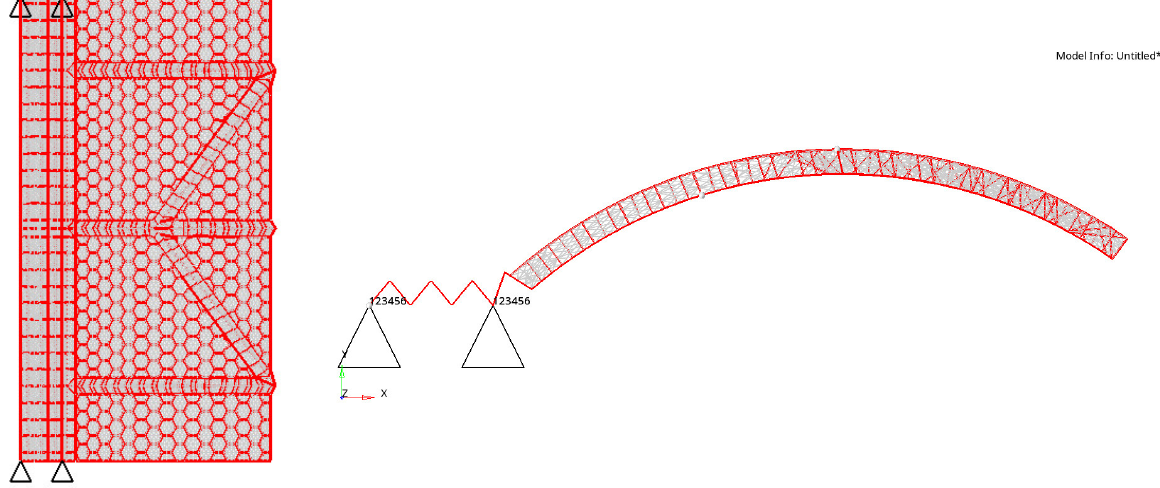
Figure 4. A schematic diagram of the carport with constraint conditions.